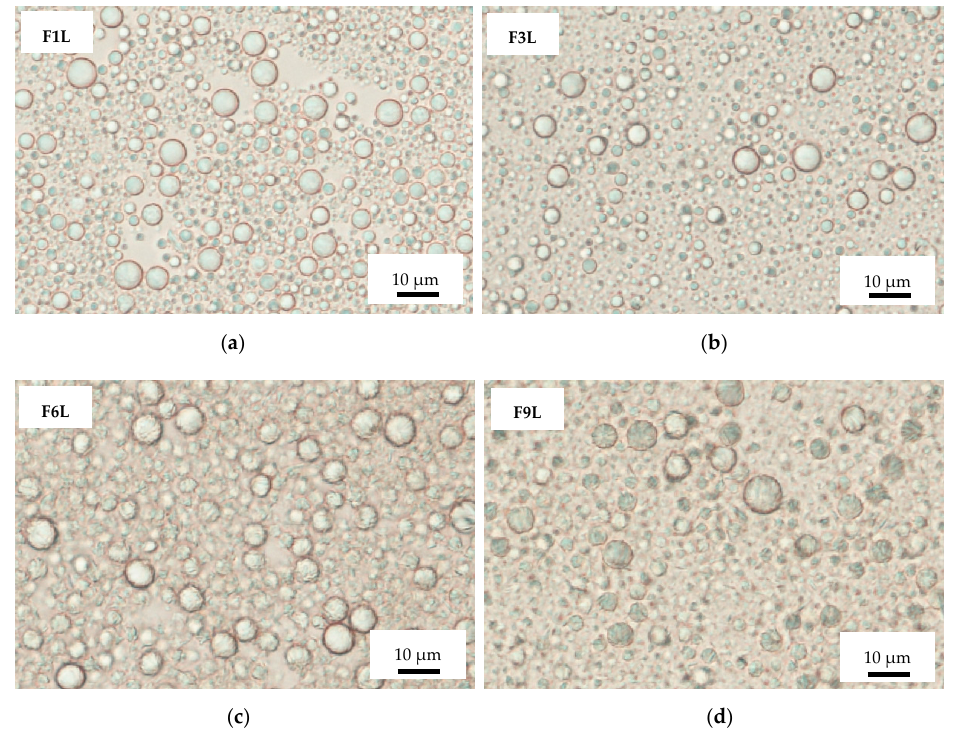
Figure 1. Optical microscopic picture of solid lipid microparticle (SLM) formulations: placebo F1L ( a ) and F6L ( c ), with cyclosporine F3L ( b ) and spironolactone F9L ( d ).